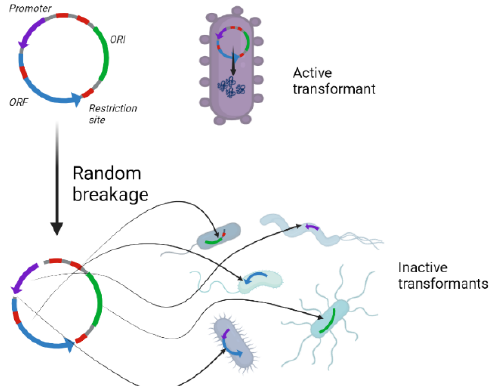
Figure 1. Resistance of the engineering technique to environmental damage. When partial gene transfer, or any other natural alteration occurs, the passed fragments will be inactive, increasing the biosafety of the engineering technique.